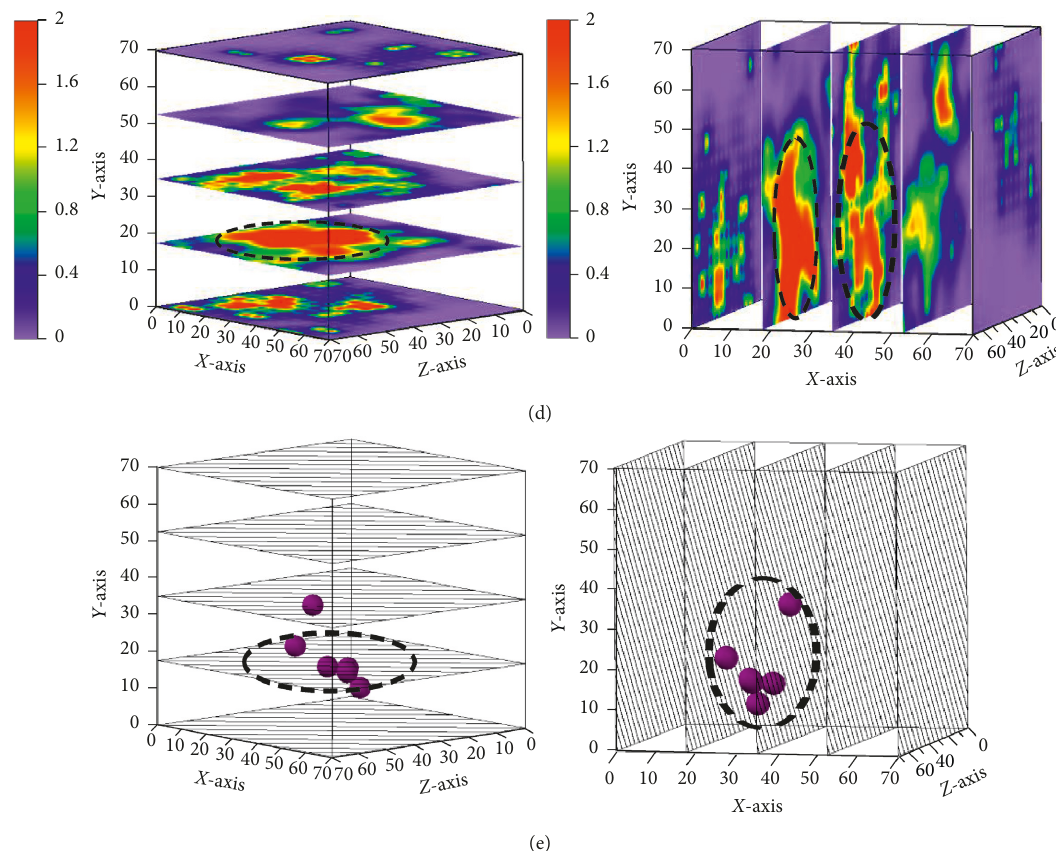
Figure 11: The energy density nephogram and shock sources at different stages: (a) loading to the triaxial stress stage; (b) true triaxial loading and unloading experimental stage I; (c) true-triaxial loading and unloading experimental stage II; (d) high-speed unloading stage (coal burst experiment); (e) burst source location